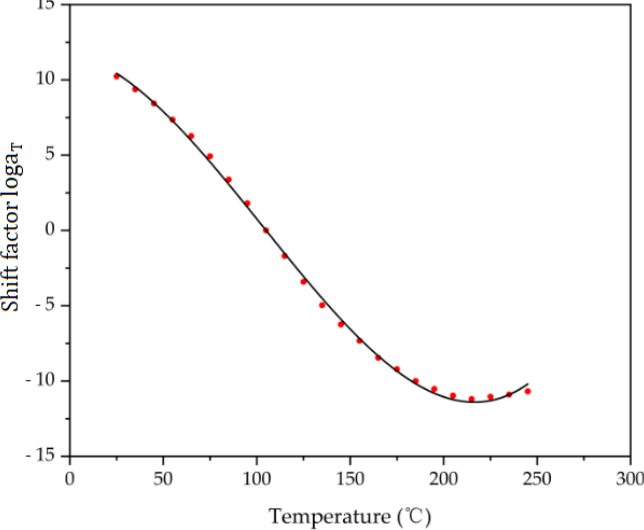
Figure 8. Shift factor scatter plot.